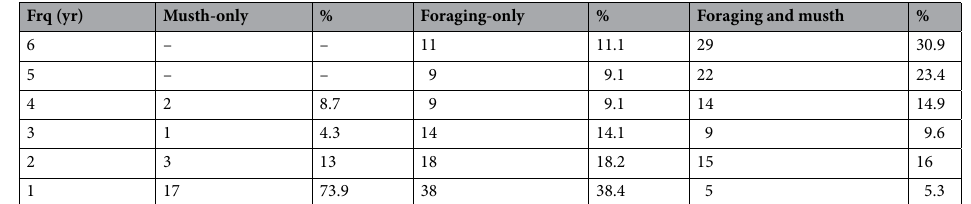
Table 1. Number of mature males (≥ 21 years) using each strategy across years. N = 216 (musth-only (m) = 23 (11%), foraging-only (f) = 99 (45%), foraging and musth (f + m) = 94 (44%)). Musth-only males are the least reliably seen across years whereas those seen in both states are most often seen across